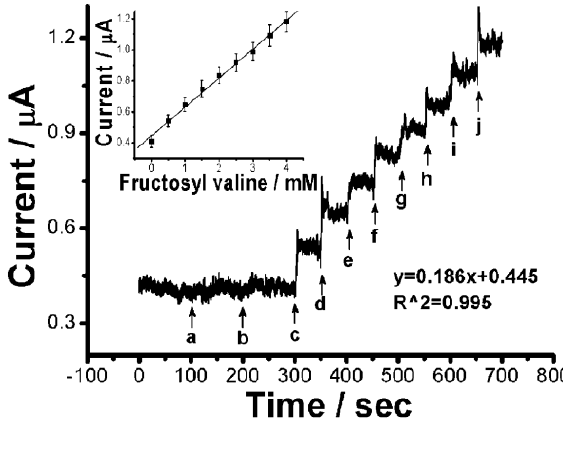
Figure 8. Amperometric response of FcBA to glucose and FV. The output current was recorded at 0.1 V vs . Ag/AgCl. 1 mM glucose ( a , b ) and 0.5 mM FV ( c – j ) were added to the sample solution. (Inset) A calibration graph for FV. Reprinted with permission from Chien et al . [24]. Copyright (2011) Wiley-VCH Verlag GmbH &